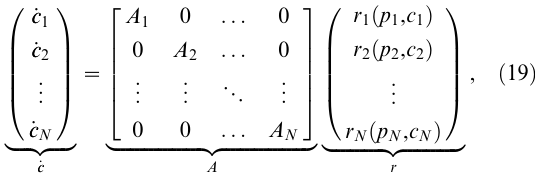
Table 1. Typical range of macroscopic parameters in Escherichia coli .